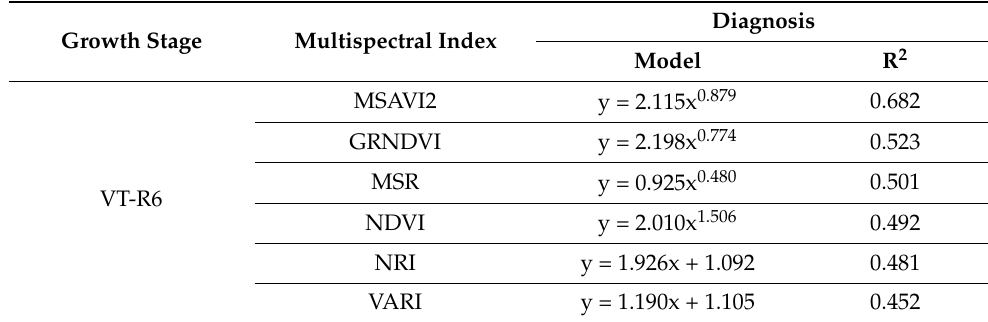
Table 3. Multispectral diagnosis models and evaluation results of the summer maize nitrogen concentration in the stages from VT to